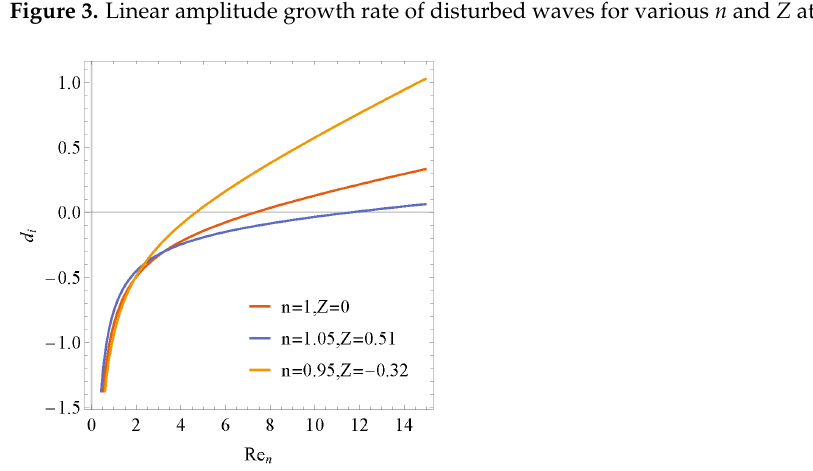
Figure 4. Linear amplitude growth rate of disturbed waves for various n and Z at α = 0.06.